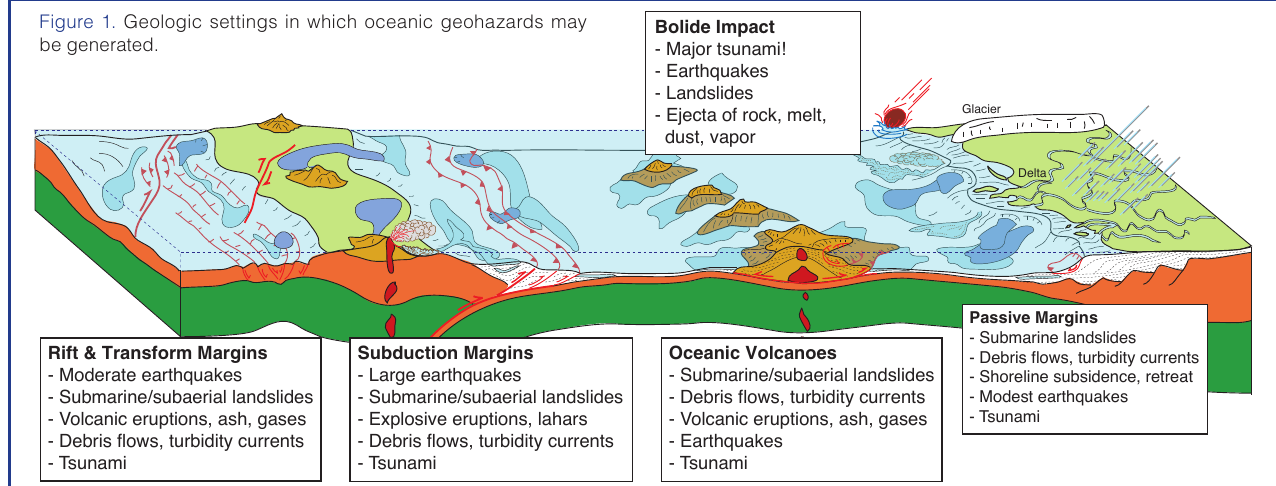
Figure 1. Geologic settings in which oceanic geohazards may be